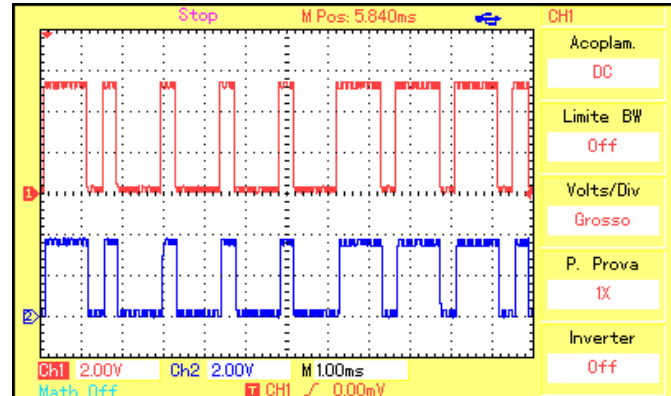
Figura 6: Sinal no transmissor e receptor. Fonte: Autores, (2018).